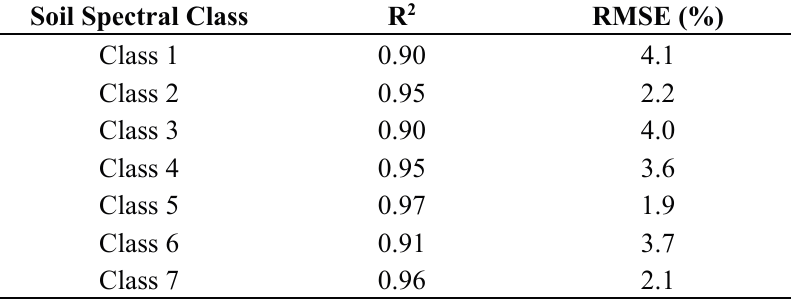
Table 4. The R 2 and RMSE values obtained with the inverse model for each a priori soil